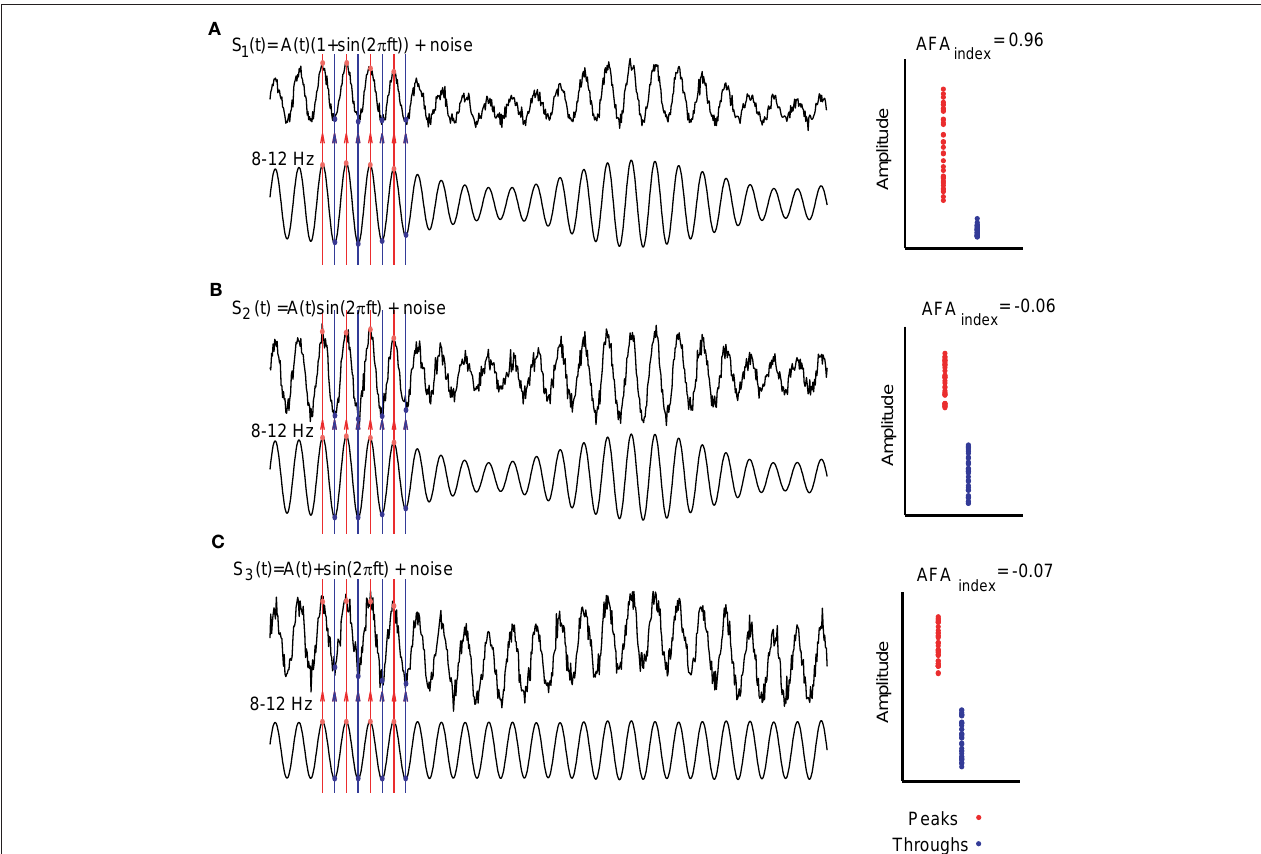
A(t), affected the alpha rhythm in a multiplicative manner. Thus peaks and troughs are modulated symmetrically over time yielding an AFA s (t) slow modulations added to the alpha oscillations (DC-like offset of the 3 signal). This affected peaks and troughs in the same direction producing an AFA close to 0. Adapted from Mazaheri and Jensen (2008). index